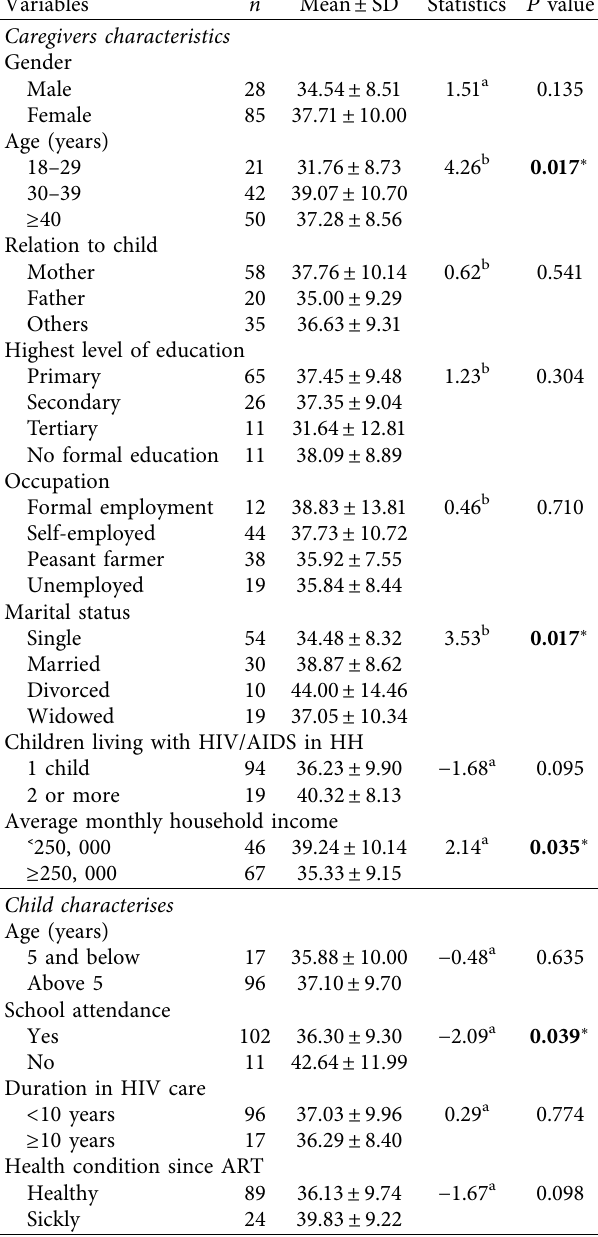
Table 3: Care burden scores and sociodemographic characteristics of caregivers of HIV-infected children in northern